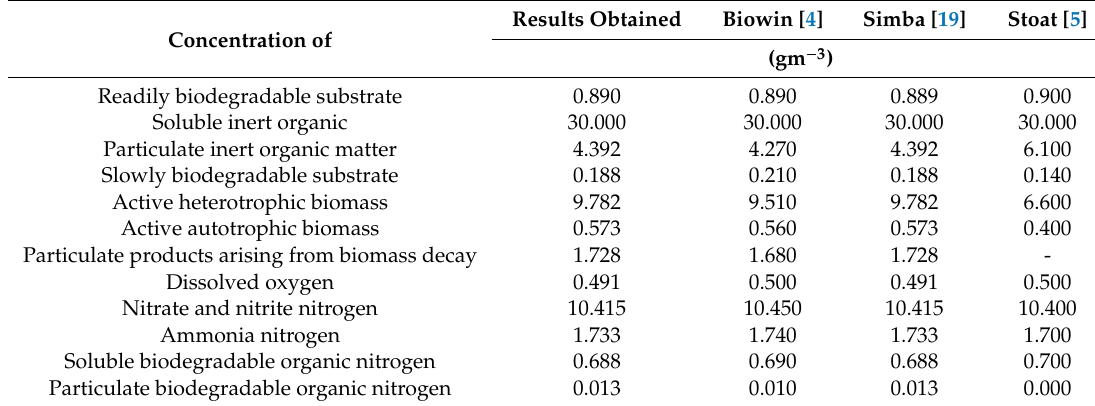
Table 2. Comparison of the e ffl uent concentrations with commercial software.